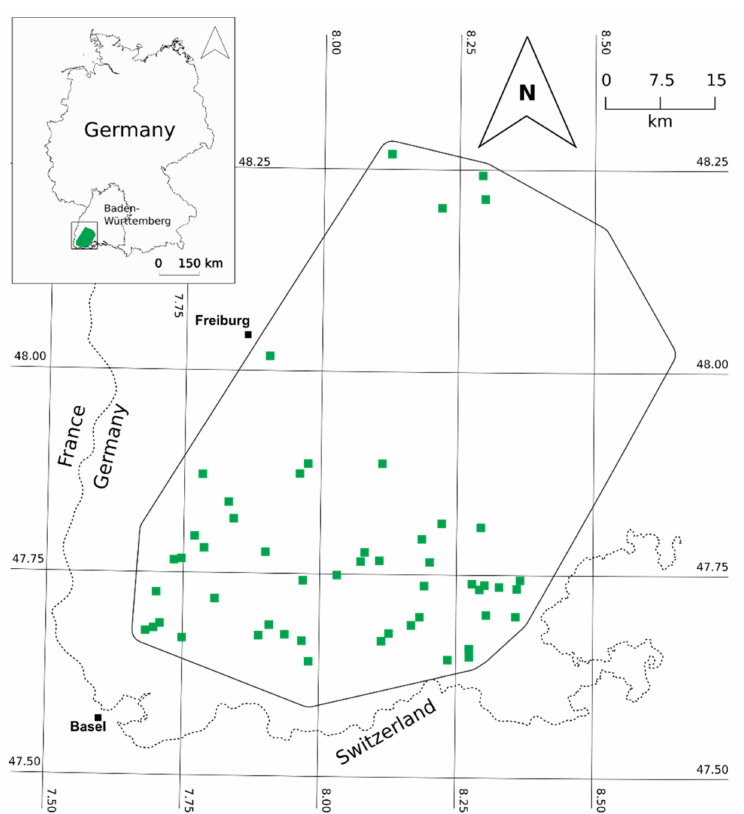
Figure 2. Map of the research area within Germany (green in top-left corner), and the location of plots where photos and scans have been taken (green